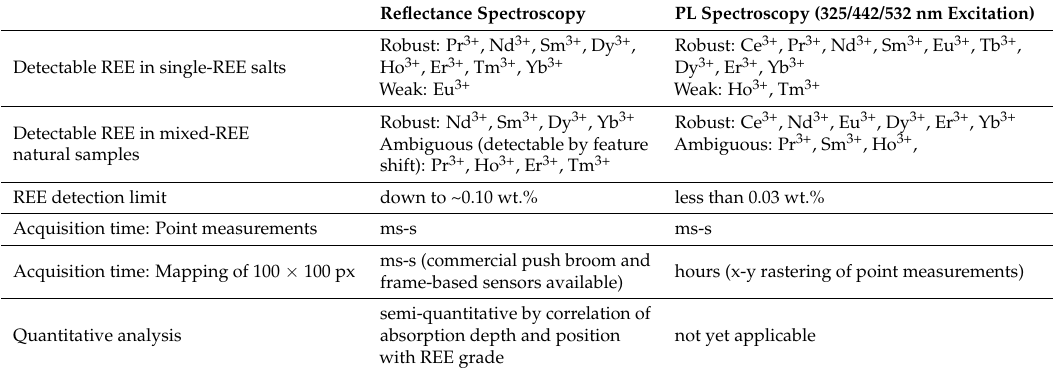
Table 4. Concluding overview on the capabilities of reflectance and PL spectroscopy for near-field REE detection.